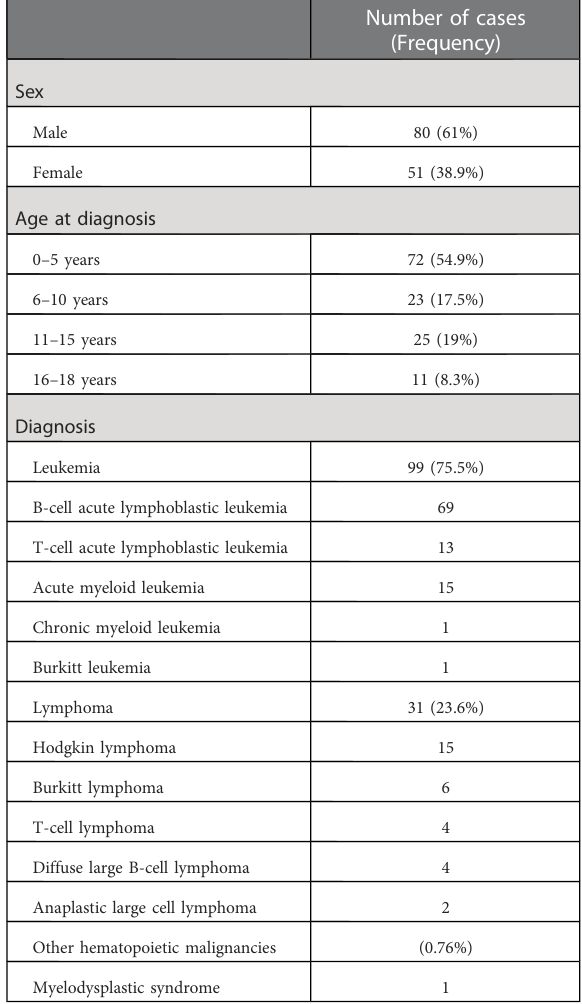
TABLE 1 Clinical characteristics of the 131 patients reported in this